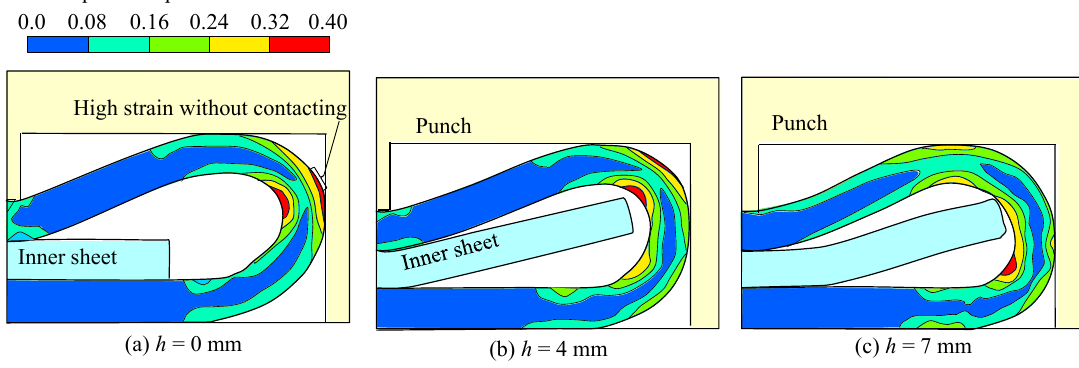
Figure 7. E ff ect of sheet height on plastic strain in outer sheet in joining stage. Figure 7. Effect of sheet height on plastic strain in outer sheet in joining stage.